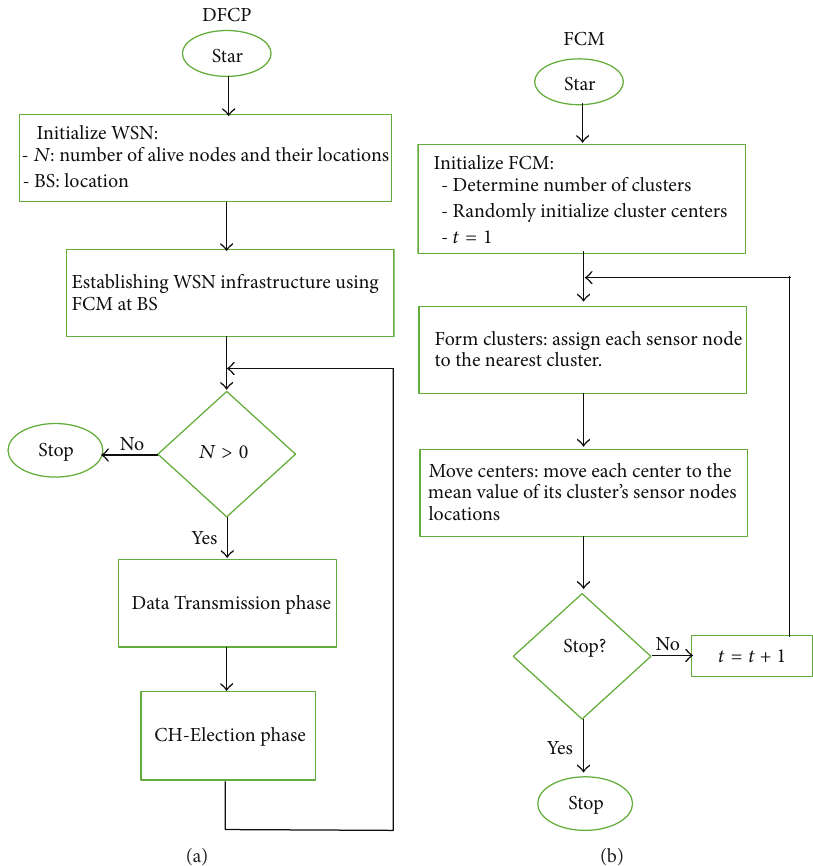
Figure 1: (a) An overview of the proposed protocol DFCP. (b) FCM